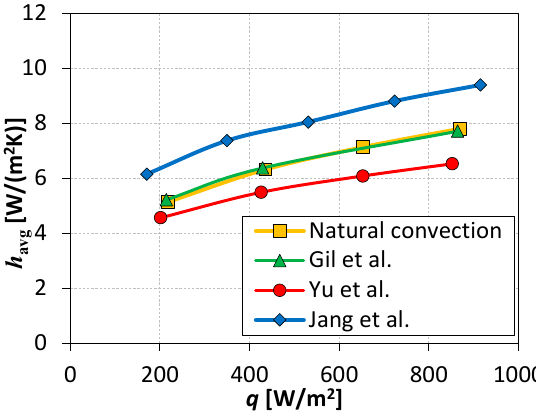
Figure 5. The average heat transfer coefficient as a function of the heater’s heat flux q . Data from: Gil et al. [ Error! Reference source not found. ], Yu et al. [ Error! Reference source not found. ], Jang et al. [ Error! Reference source not found. ].